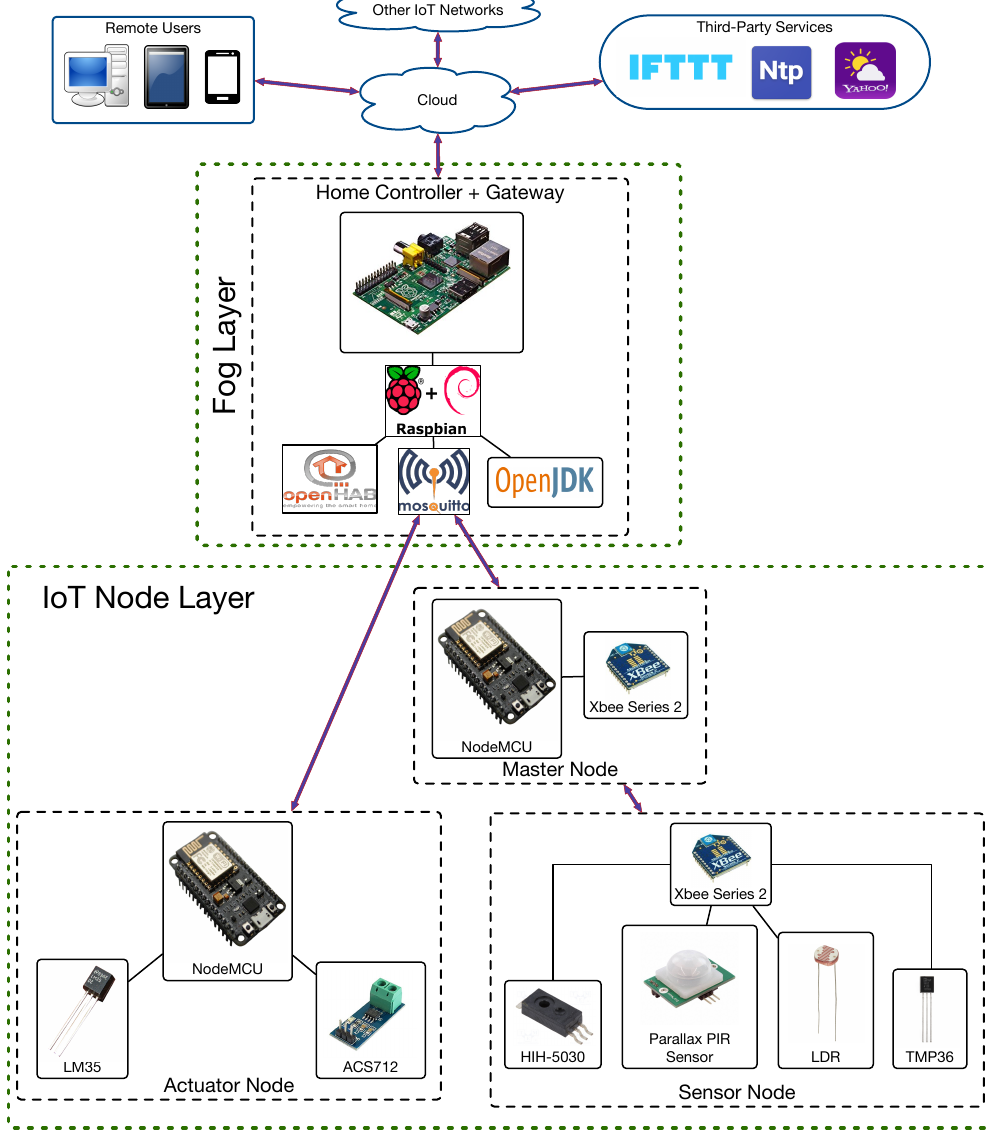
Figure 15. Communications architecture for the demo